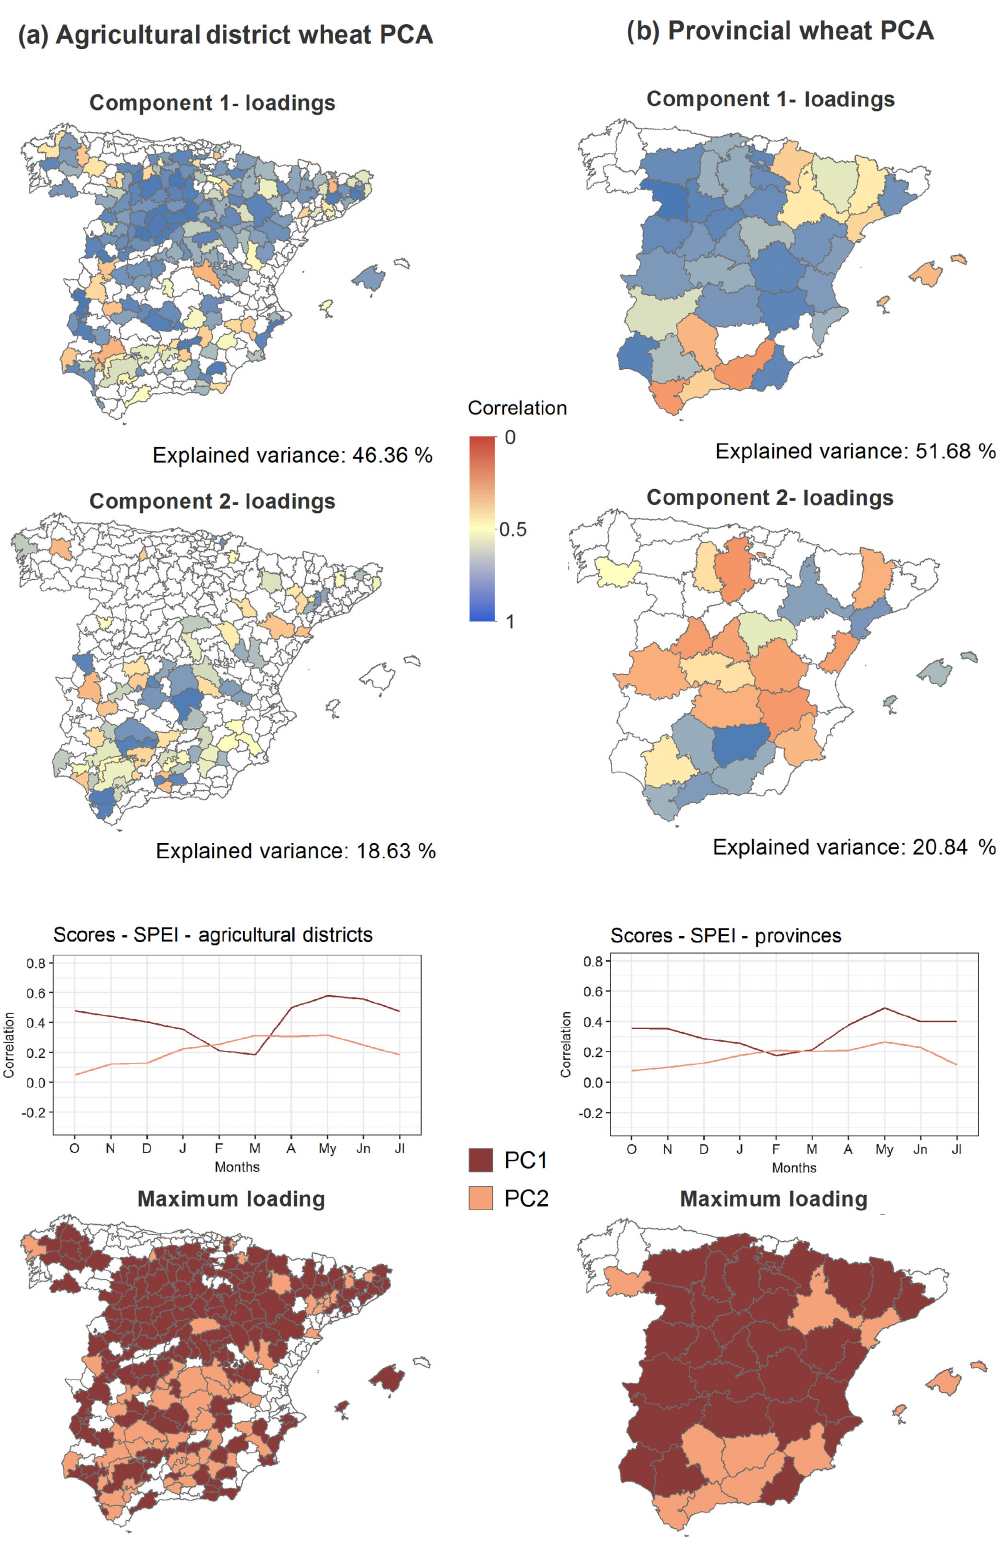
Figure 7. PC loadings, PC scores, timescales, and maximum loading rules from the PCA for monthly maximum correlation coefficients between the SPEI and wheat yields at the agricultural district (a) and provincial (b) scales, independently of the timescale. The PC loadings and maximum loadings were significant at p < 0 .